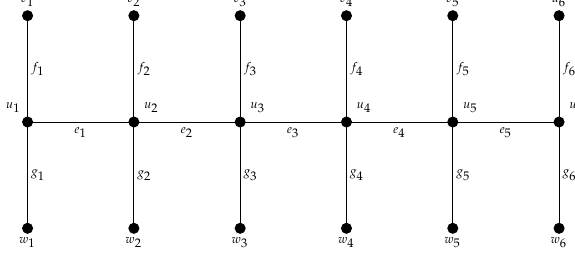
Figure 9. Double comb graph DCO